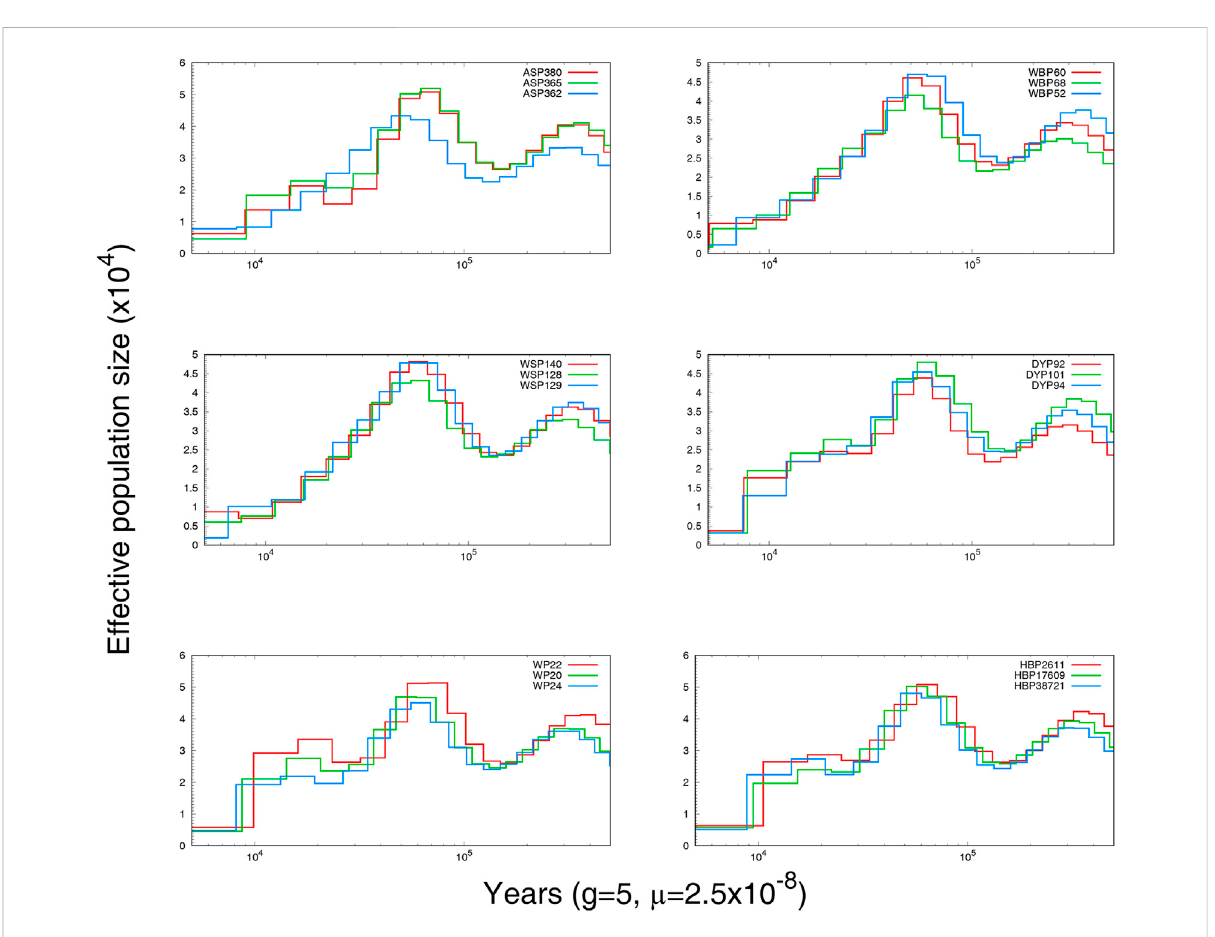
FIGURE 3 The effective population size and history of Anhui